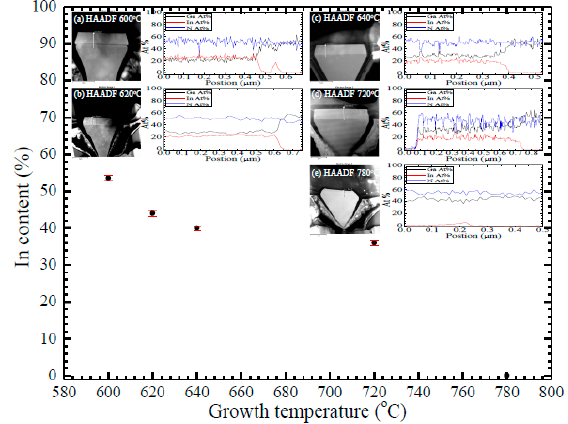
Figure 6. The In contents for sample F, D, G, H, and I. The insets show the dark field TEM images and the constituent spectra in line scanning mode obtained by EDS, where the scanning lines are marked on the TEM images.